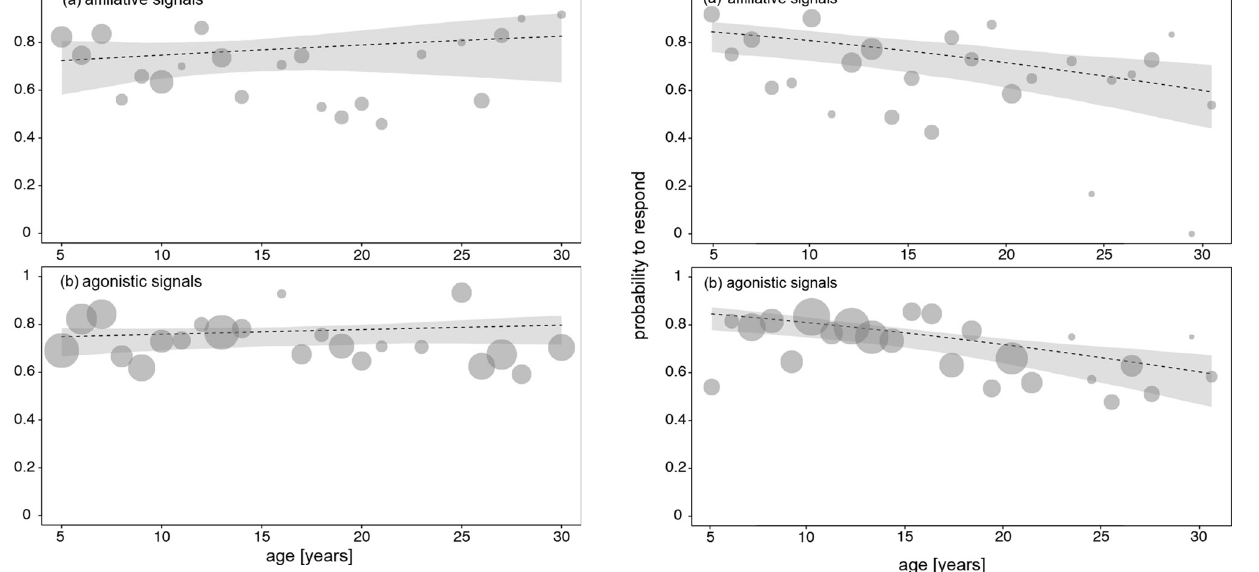
Fig. 3 Effect of signaller age on the probability of females to respond to a signal. a Probability to respond to af fi liative signals in relation to signaller age ( N = 846 events involving 50 female receivers). b Probability to respond to agonistic signals in relation to signaller age ( N = 2269 events involving 50 female receivers). The area of the points represents the number of events per age (range: 4 to 264). Dashed lines and the grey polygons indicate the fi tted model and its (2.5 and 97.5%) con fi dence limits (for all other terms in the model being centred to a mean of zero).